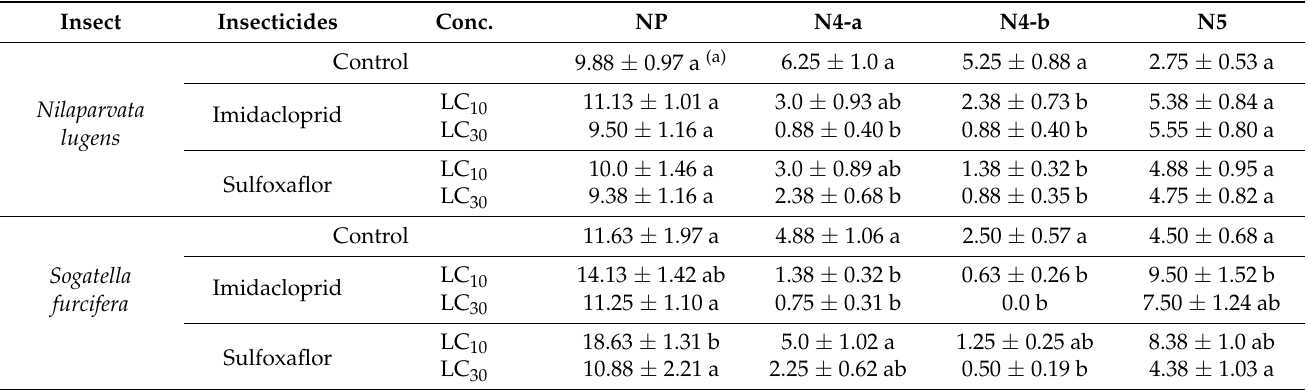
Table 3. Relationship between the two insecticide concentrations and the number of occurrences of each EPG waveform for Nilaparvata lugens and Sogatella furcifera .